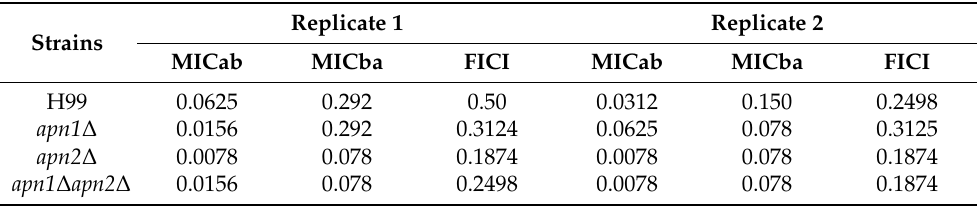
Table 2. MIC values of amphotericin B (AmpB) and methoxy-amine hydrochloride (MX) in combina- tions and fractional inhibitory concentration index (FICI)